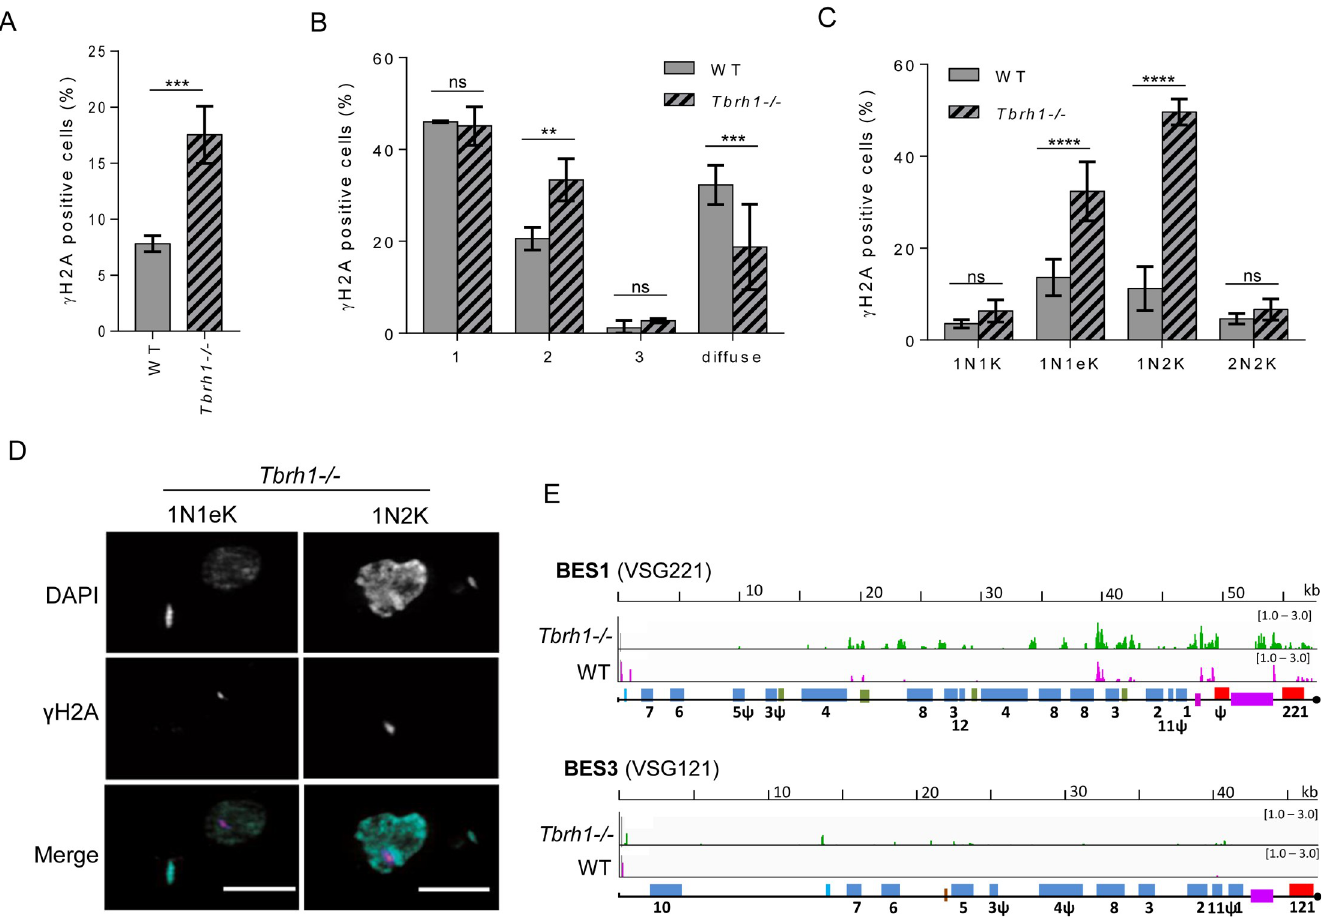
Fig 6. Loss of T . brucei RNase H1 leads to increased levels of nuclear damage in replicating cells and in the VSG expression site. A. Percentage of WT and Tbrh1 -/- cells (n > 200 in each of three replicates) that have detectable nuclear anti- γ -H2A signal. Data shown as mean +/- SD; ��� P < 0.001 (unpaired t-test). B. Distribution of intra-nuclear γ -H2A signal in WT and Tbrh1 -/- cells (n > 200 in each of three replicates). Data shown as mean +/- SD; �� P < 0.01, ��� P < 0.001, ns not significant (two-way ANOVA test). C. Percentage of cell cycle stages in WT and Tbrh1-/- cells with nuclear anti- γ -H2A signal; cell cycle stages were determined by DAPI staining and fluorescent imaging followed by counting the number and shape of nuclear (N) and kinetoplast (K) structures in individual cells: 1N1K, 1N1elongated K (1N1eK), 1N2K and 2N2K (n � 50 for each cell cycle stage in three replicates). Data shown and analysed as in C; ���� P < 0.0001. D. Super-resolution structure-illumination microscopy imaging of anti- γ -H2A signal and co-localisation with DAPI in representative replicating (1N1eK and 1N2K; see below) Tbrh1-/- cells; only in the merge of anti- γ -H2A (magenta) and DAPI (cyan) images is colour provided (further examples of mutant and WT cells are provided in S5 Fig). E. Localisation of γ -H2A by ChiP-seq in WT and Tbrh1-/- cells. ChiP-seq signal is shown mapped to BES1 and BES3, which are represented as in Fig 2. Magenta and green tracks show normalised ratios of read-depth fold-change (1–3 fold) in IP samples relative to input in WT and Tbrh1 -/- mutants, respectively.